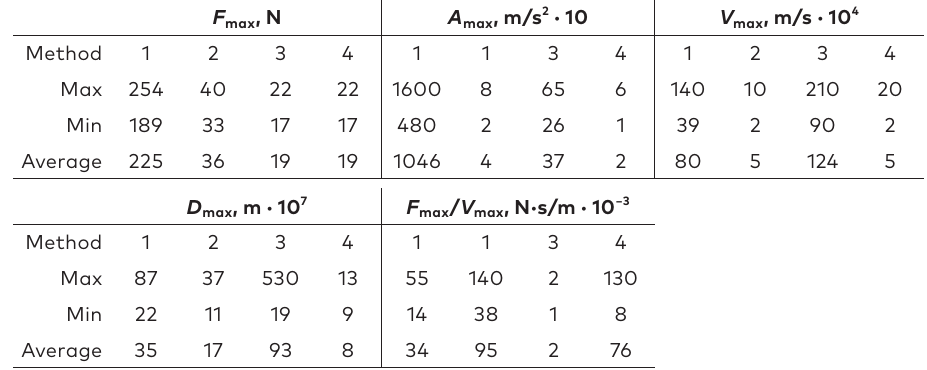
Table 8 focuses on how different parameters (e.g., domain depend on the method for different samples. Three replicates per test were carried out. The average values